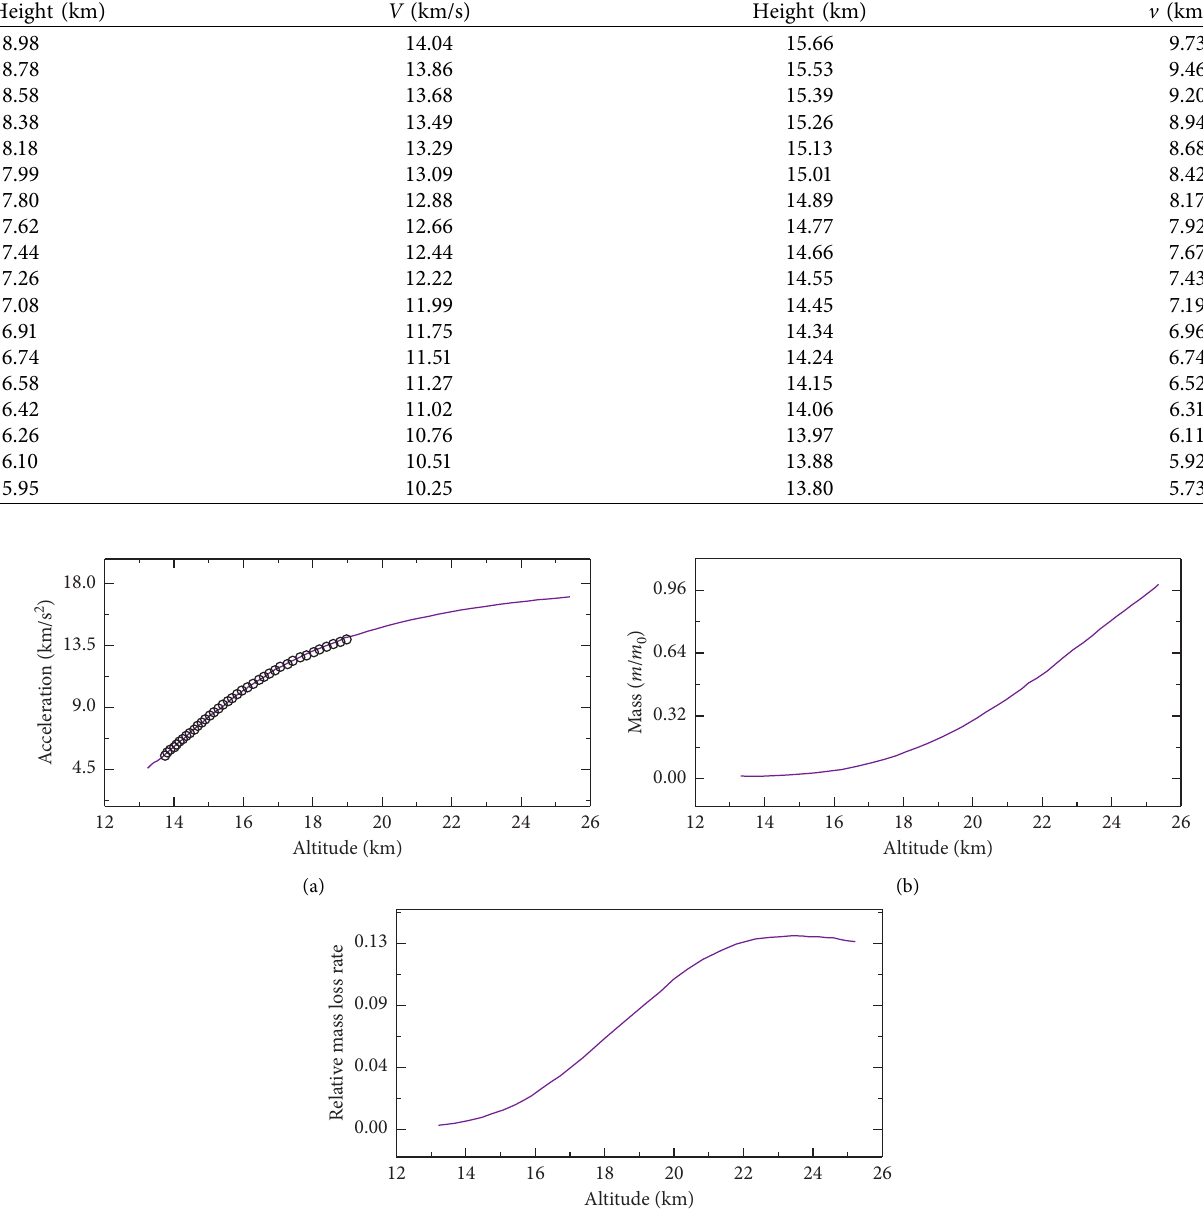
Table 2: Dynamic data of the Chelyabinsk